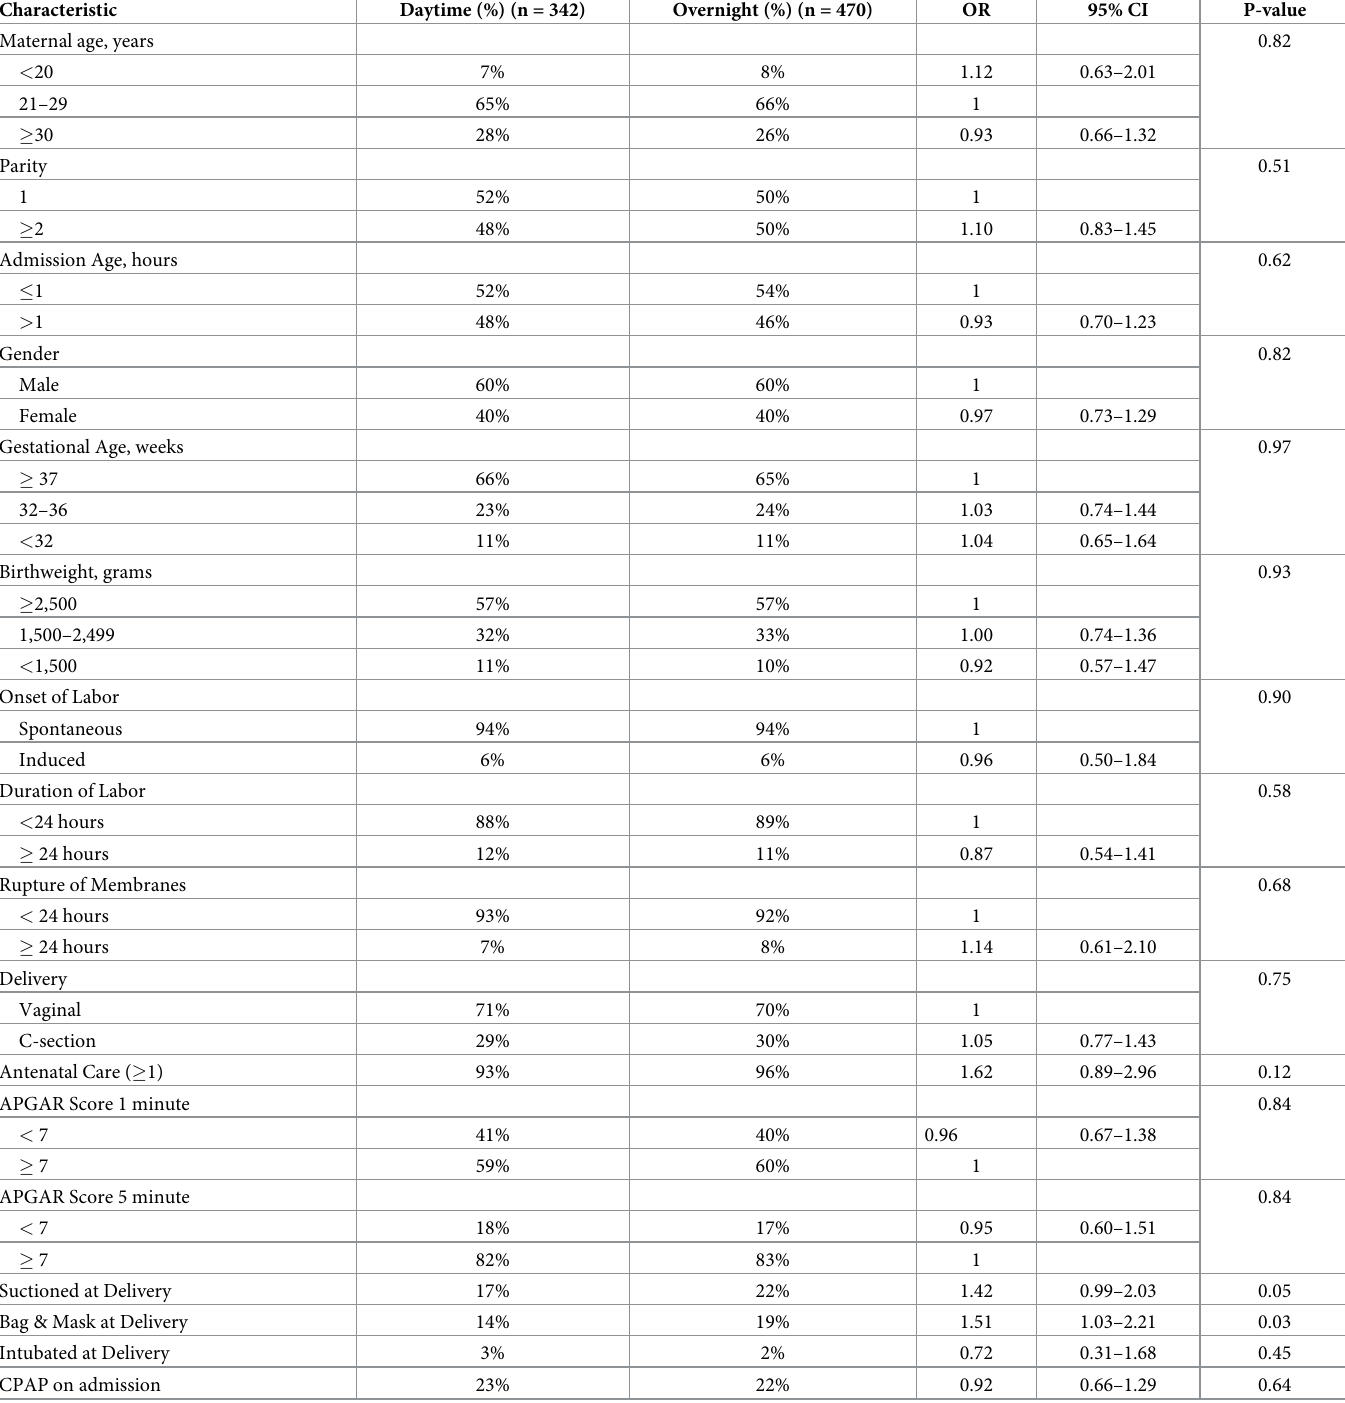
Table 2. Comparison of characteristics admitted to the NICU during daytime and overnight